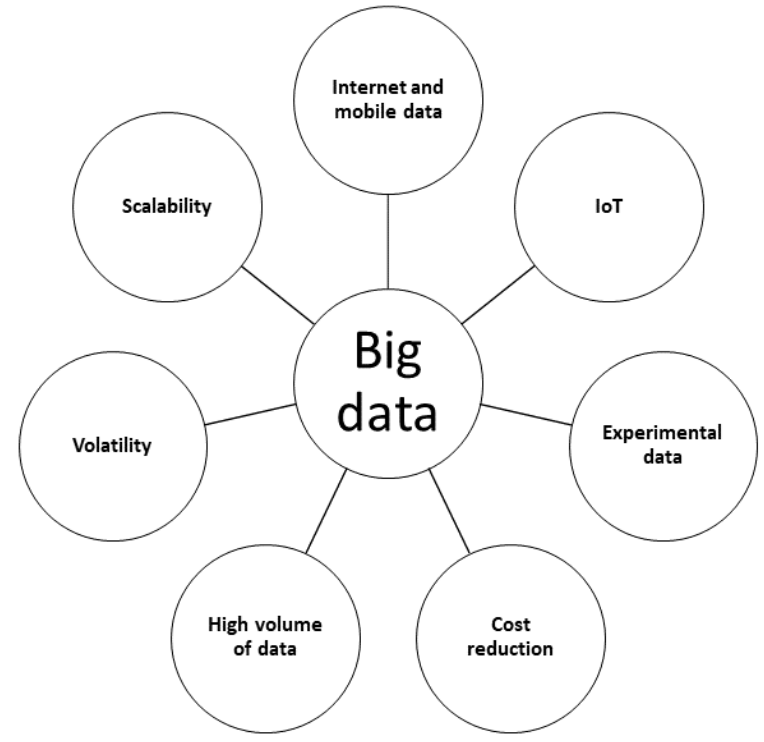
Figure 3. Big Data characteristics and technologies that compose it.